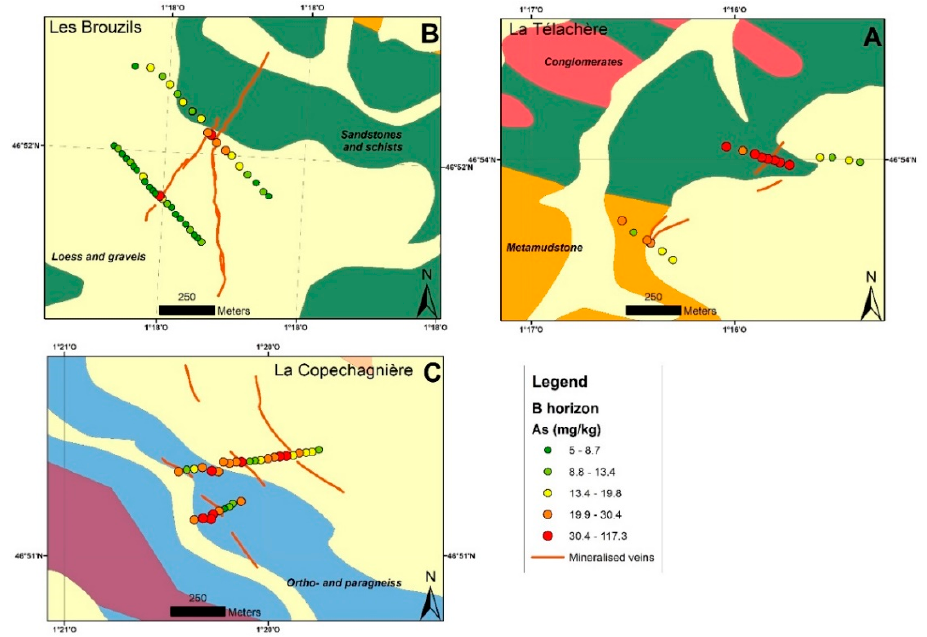
Figure 15. As map of B horizon samples (pXRF measurements in mg/kg). ( A ): La Télachère; ( B ): Les Brouzils; ( C ): La Copechagnière.